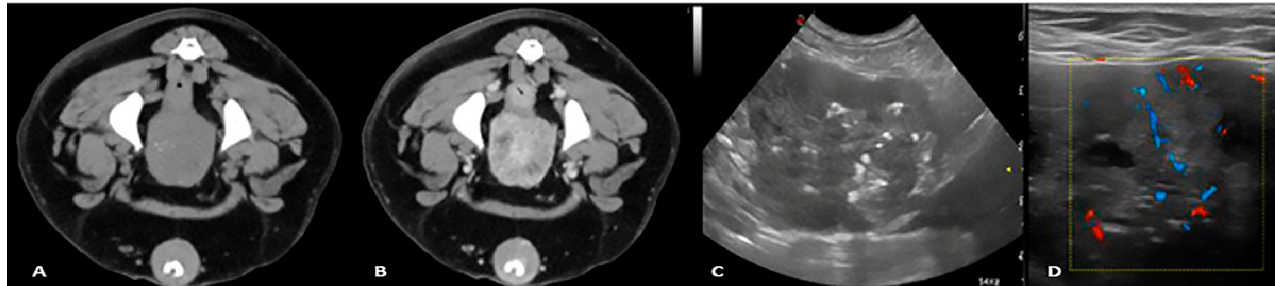
Figure 3. Pre and postcontrast CT study ( A , B ), transverse US image, ( C ) and Colour Doppler image ( D ) of a 9-year-old mixed breed dog with prostatic carcinoma. The precontrast study shows fine mineralisation of the prostatic parenchyma; the postcontrast study shows a severely heterogeneous prostate with inhomogeneous contrast enhancement. The B-mode image shows that the prostatic gland has an irregular margin and heterogeneous echotexture with scattered echogenic foci and irregular hypoechoic cyst-like lesions. The Colour Doppler shows irregular branching of arterial vessels throughout the prostatic parenchyma.